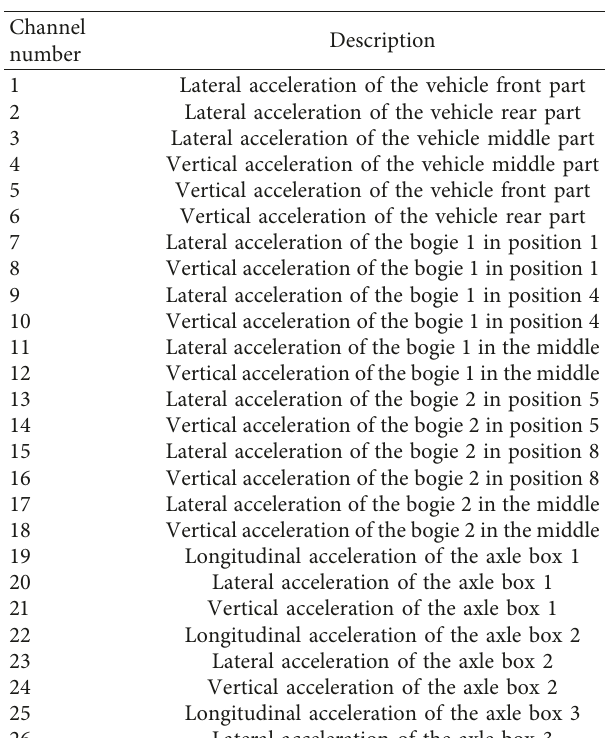
Table 1: Channel descriptions of monitoring sensors on the